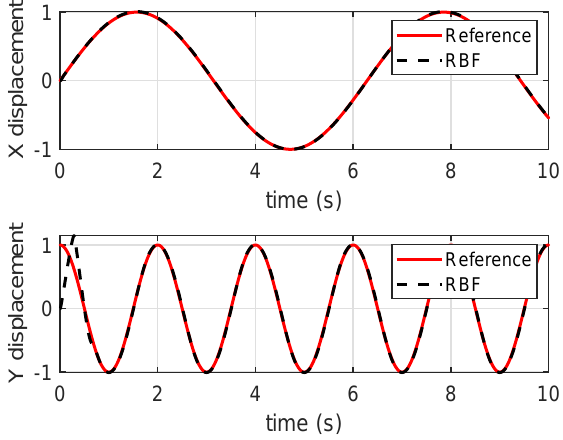
Figure 9. Tracking results when references were without